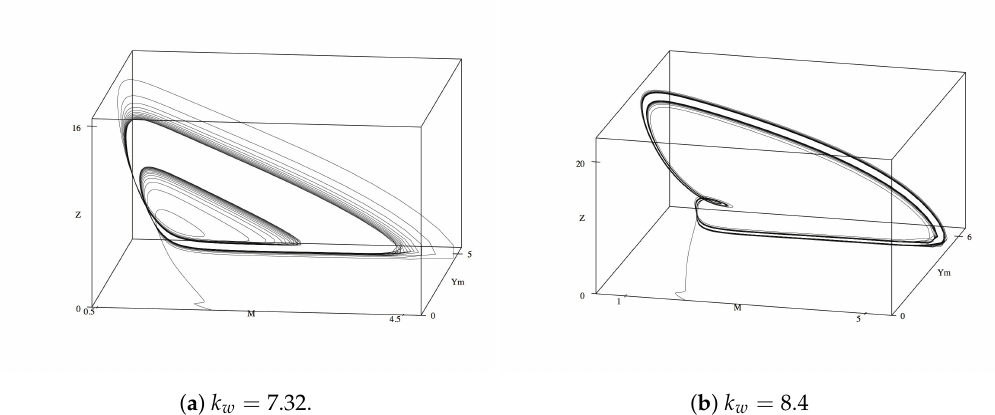
Figure 3. Phase plane diagrams for ( Y m , Y , Z ) for varying k w and same parameters as in Figure 1.